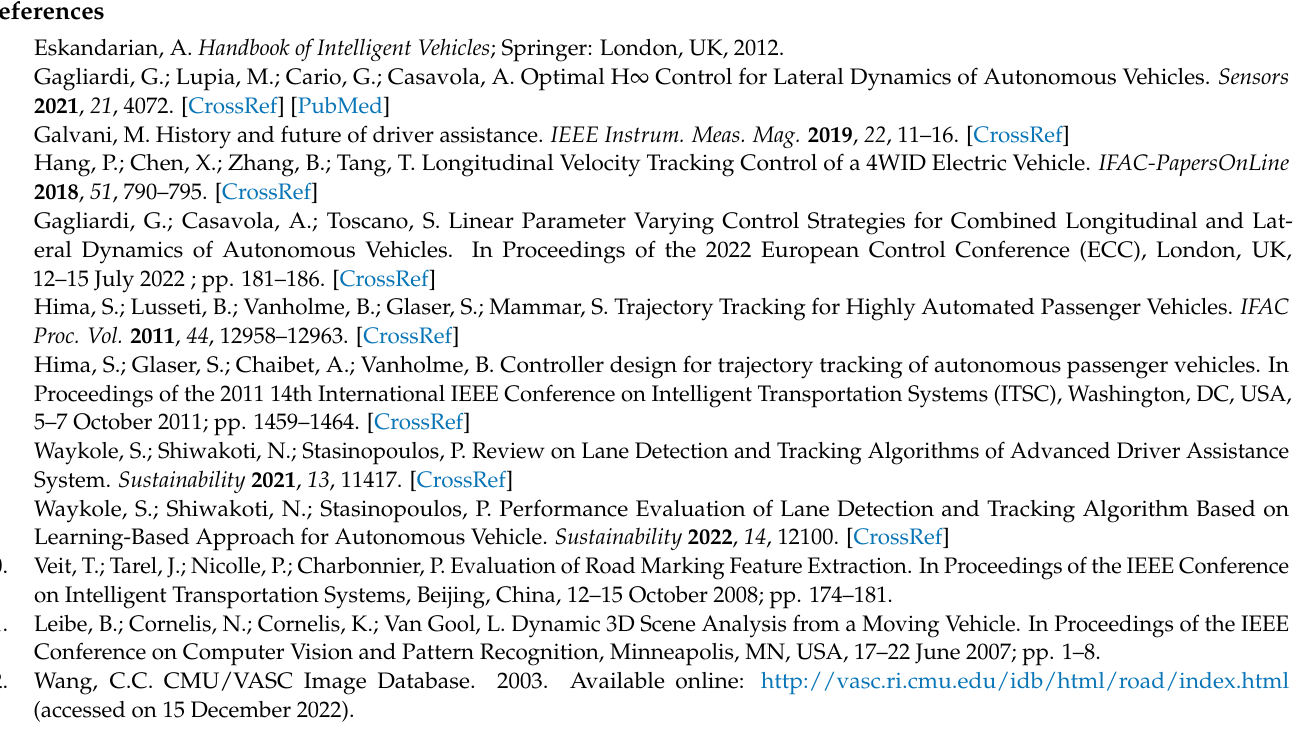
Figure A1. XML file generated from the proposed interpolation approach.